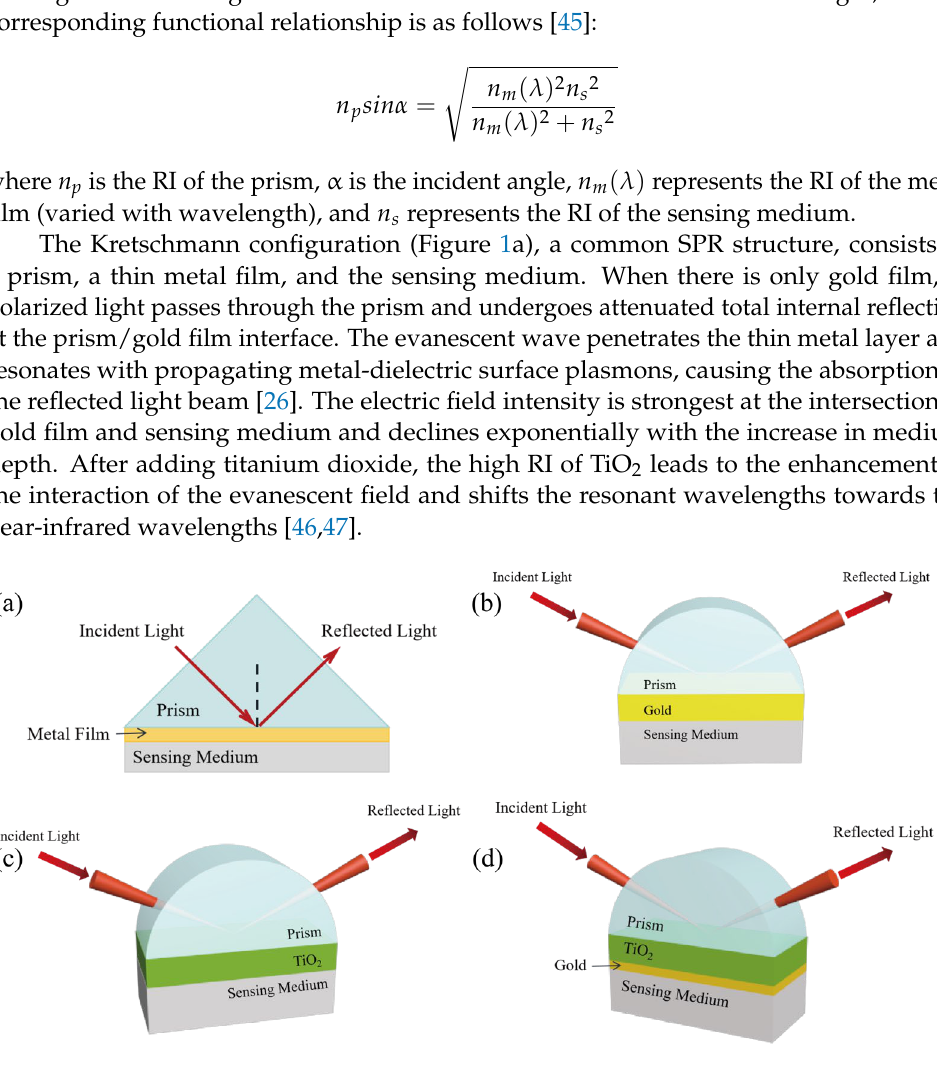
Figure 1. ( a ) Schematic diagram of Kretschmann configuration. ( b ) Schematic diagram of a pure gold (Au) SPR sensor. ( c ) Schematic diagram of pure titanium dioxide (TiO 2 ) SPR sensor. ( d ) Schematic diagram of the proposed TiO 2 -Au dual-structure SPR sensor.